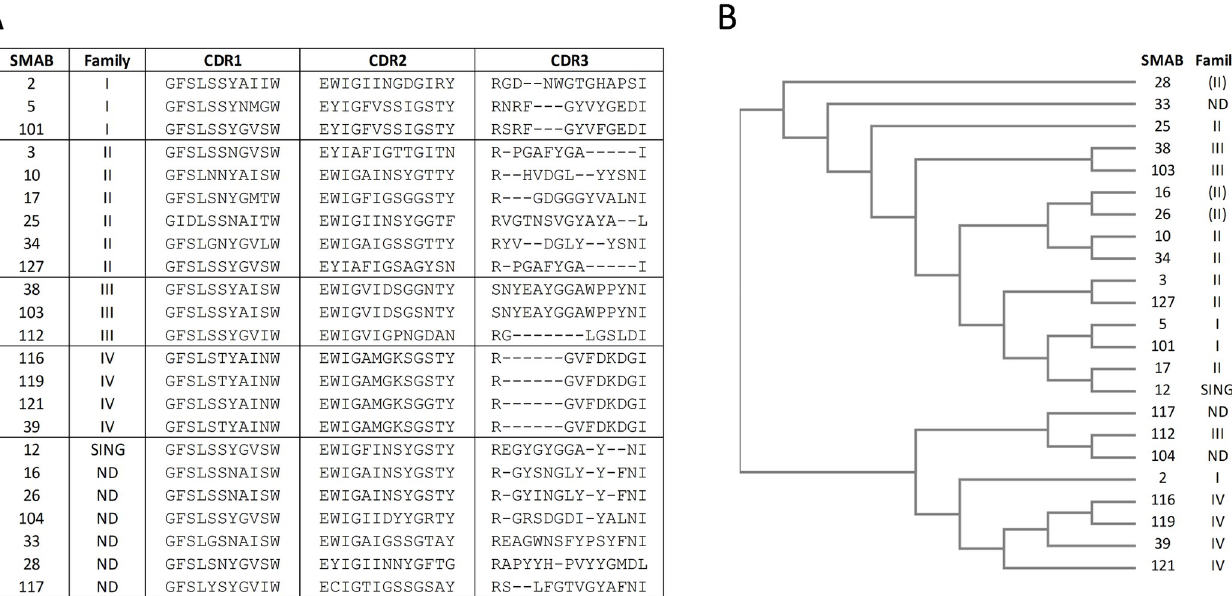
Fig 3. Heavy chain SMAB sequence analysis. (A) Heavy-chain CDR sequences and (B) a corresponding cladogram illustrating the similarity between SMABs. Family numbers in parenthesis correspond to tentative inferred assignments.